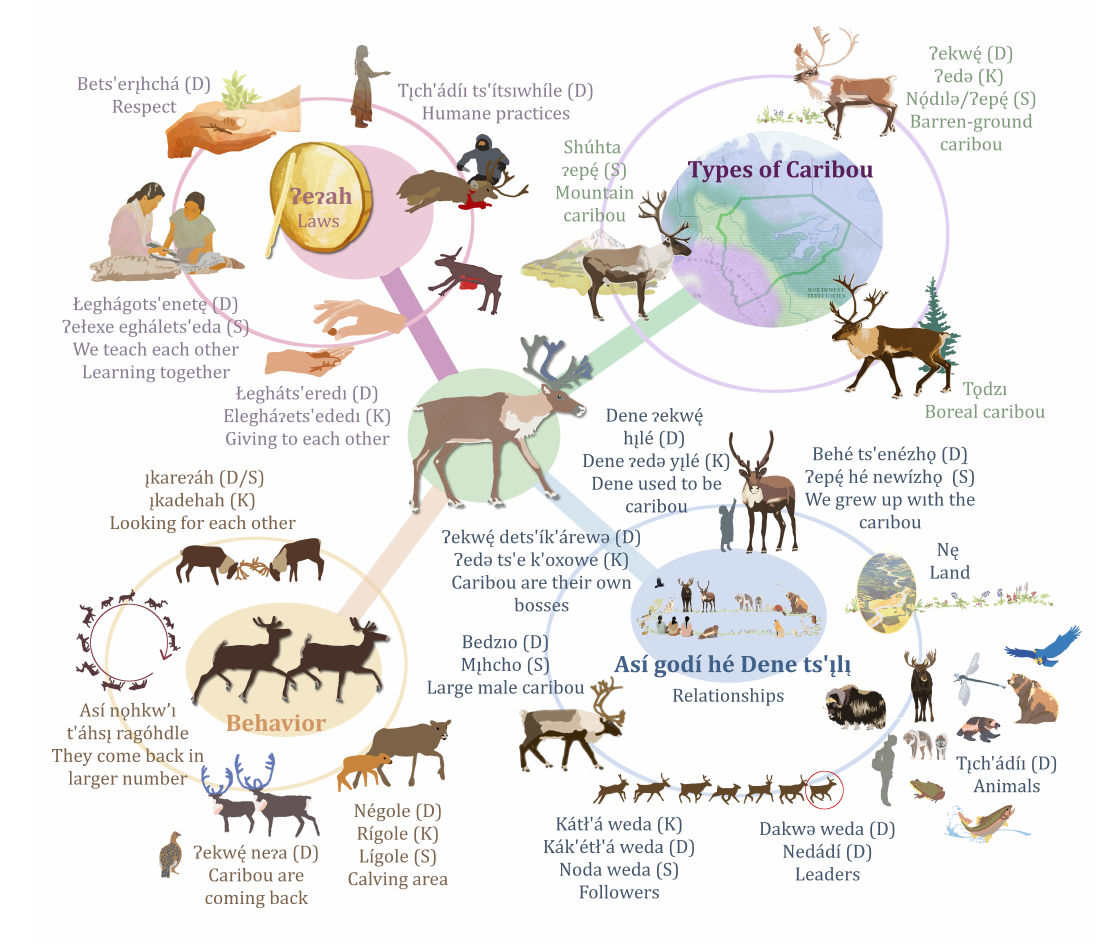
Fig. 4 . The research mind map diagram was developed to explore concepts and connections between Dene themes and research questions related to caribou with advisory group participants in June 2014. Where possible, thematic topics that were used to guide the agenda and focus discussions are represented with Dene concepts and Dene imagery. The topic areas are clockwise from top left: 1. Ɂ e ɂ ah “Dene laws,” 2. Types of caribou, 3. Así godí hé Dene ts'ı ̨ lı ̨ “relationships,” and 4. Caribou behavior. Images were drawn by the lead author. Shúhta (S) “mountain” dialect spoken in Tulít'a, Sahtú (D) “Bearlake” dialect spoken in Délı ̨ n ę , and K'áhsho (K) “Hare” and Dela dialects spoken in Fort Good Hope and Colville Lake. We use the abbreviations S, D, and K following Dene words to distinguish